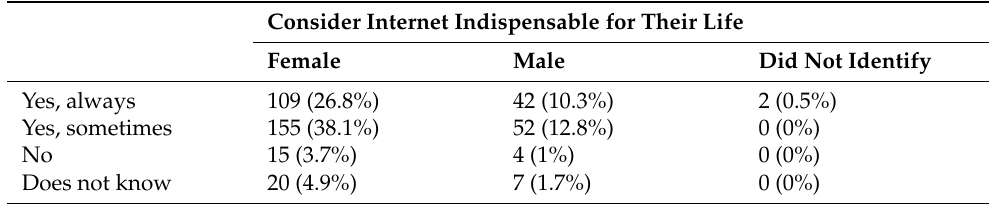
Table 5. Indispensability of the Internet and awareness of being online for too long by gender. Consider Internet Indispensable for Their Life